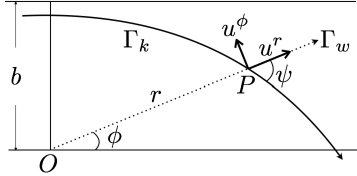
Figure 1. Schematic diagram of light trajectory. Γ k (bold line) is the trajectory of the light ray which we now investigate, Γ w (dotted line) is the radial null geodesic connecting the center O and the position of observer P and the measurable angle ψ is the angle of intersection between Γ k and Γ w at P . Two bold vectors u r and u φ at P indicate the directions of the r (radial) and φ (transverse) components of the 4-velocity u µ . The direction of the time component u t is perpendicular to this schematic